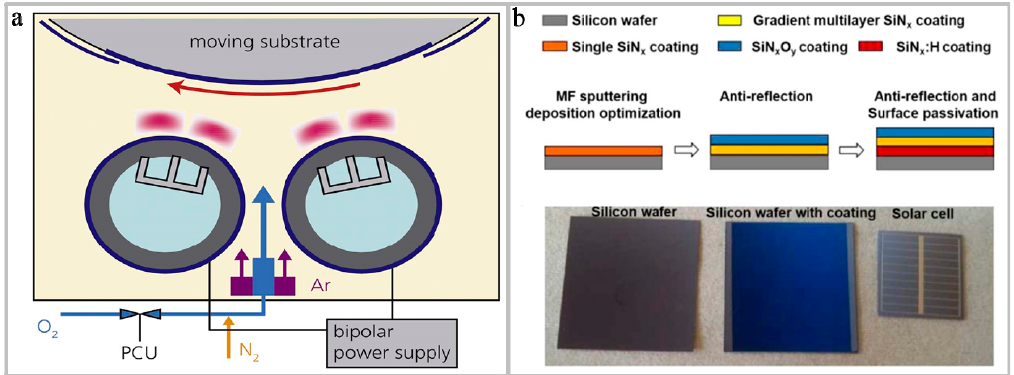
Figure 2. Physical vapor deposition (PVD). ( a ) Schematic of the deposition zone inside the roll-to-roll tool [32]. Copyright 2018, Surf. Coat. Technol . ( b ) The procedure design and application for laboratory